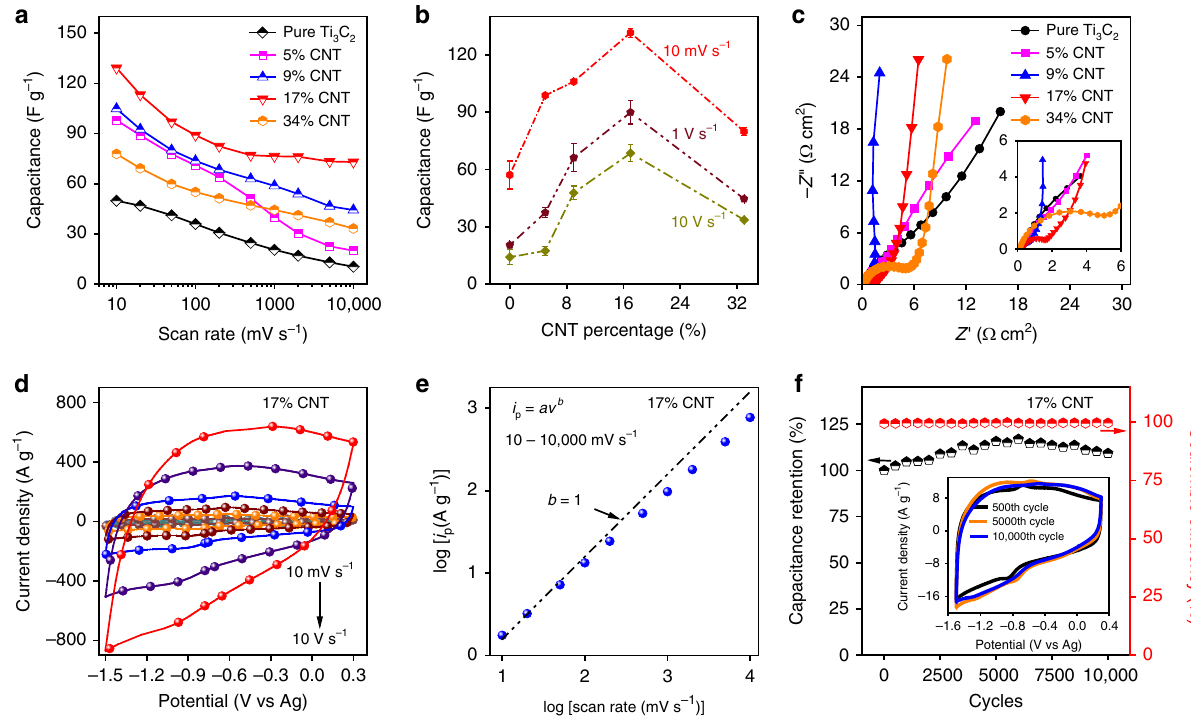
Fig. 3 Electrochemical analysis of the MXene-knotted CNT composite electrodes in an organic mixed electrolyte (EMIM-TFSI: Li-TFSI = 1:1). a Rate performance of the electrodes with different CNT contents from 0% (pure Ti 3 C 2 ). b Capacitance of the electrodes as a function of CNT content at 10 mV s − 1 , 1 V s − 1 , and 10 V s − 1 . The error bars represent the standard deviation. c Electrochemical impedance spectroscopy (EIS) data for the different electrodes taken at 0 V versus open circuit voltage. The inset showed a magni fi ed view of the high-frequency region. d Cyclic voltammograms at different scan rates, e plot of the anodic peak current versus the scan rate, and f long-term cycling performance and corresponding Coulombic ef fi ciency at 100mVs − 1 for the 17% CNT